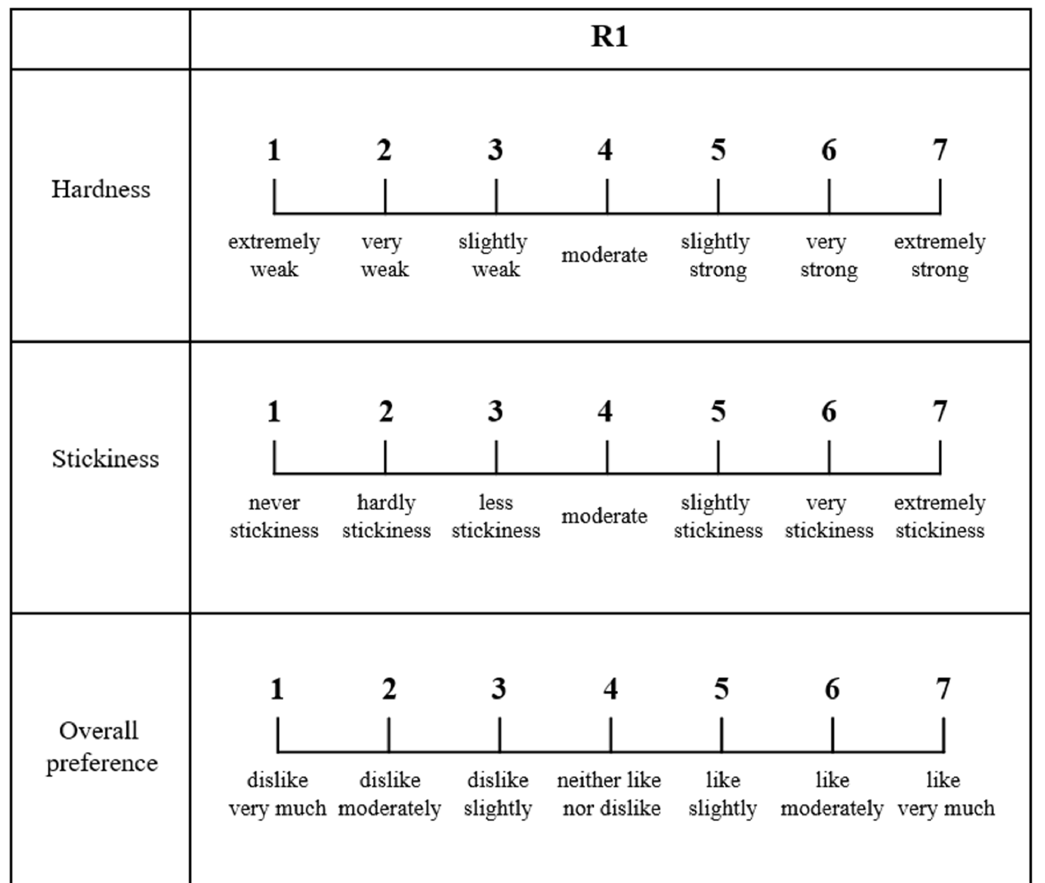
Figure 2. Sensory evaluation form for commercial rice noodles in